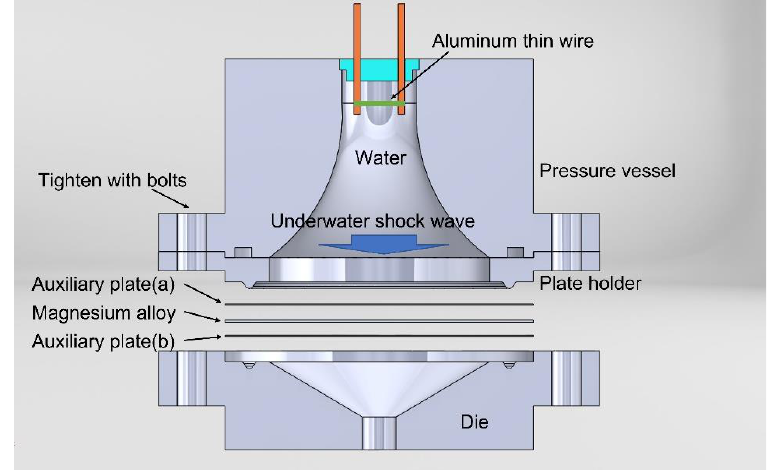
Figure 6. Cross-sectional view of the assembled forming equipment.